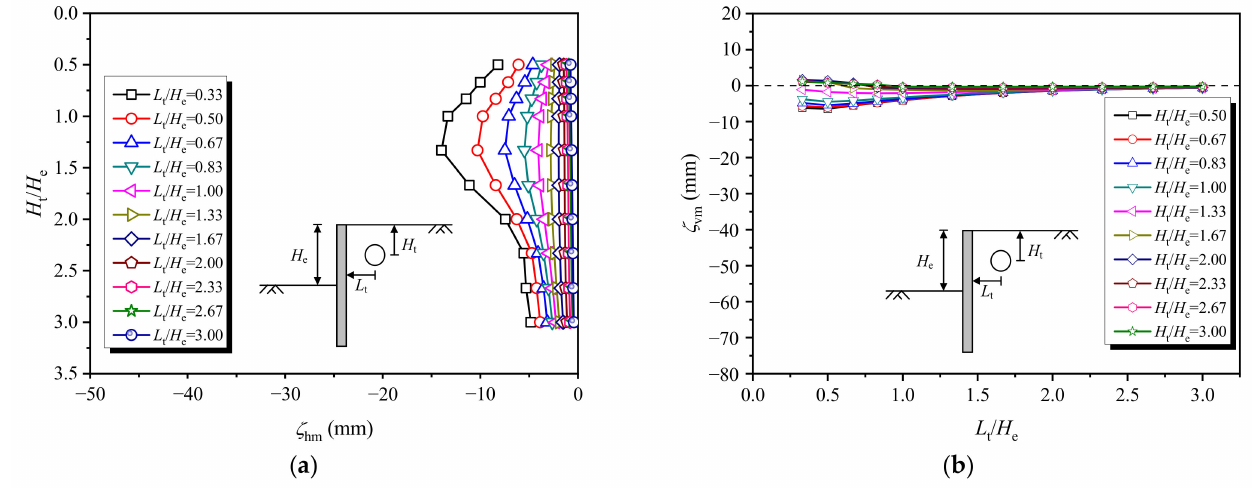
Figure 14. The maximum displacement of tunnels at different positions after ground improvement: ( a ) horizontal displacement; ( b ) vertical